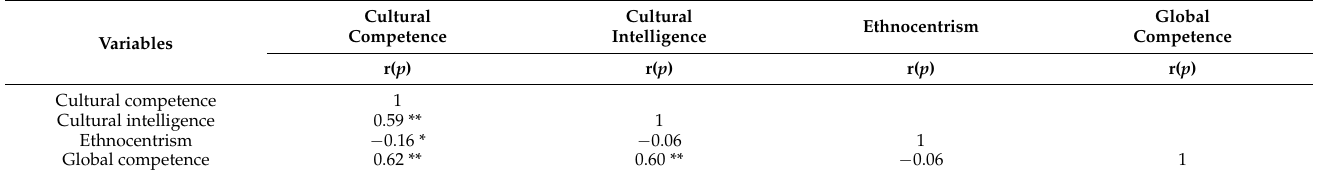
Table 3. Correlations of cultural intelligence, ethnocentrism, global competence, and cultural compe- tence (N = 235).